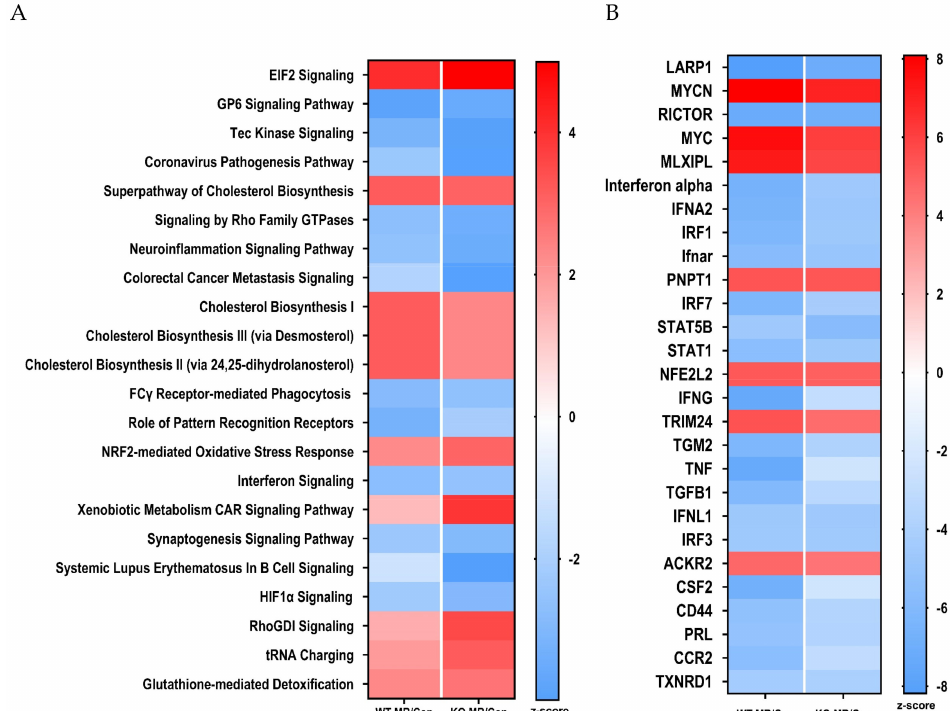
Figure 3. Bioinformatics analysis of hepatic gene expression in Nfe2l2 fl/fl (WT) and Nfe2l2 fl/(Alb) ( NRF2 KO) mice fed Con or MR diets for 8 weeks. Canonical pathway analysis ( A ) and upstream regulator analysis ( B ) were conducted using Ingenuity Pathway Analysis as described in the Materials and Methods. Pathway analysis was conducted using livers from 5 to 6 mice of each genotype × diet combination and utilized to identify putative gene regulators responsible for the observed transcriptional patterns produced by the MR diet compared to the Con diet in the two genotypes. Upstream regulators and canonical pathways with an activation z-score ≥ 2 or ≤ 2 were considered to be activated (red) or inhibited (blue), respectively. Heat maps were used to visualize the top 20 canonical pathways and upstream regulators that were differentially affected by the MR diet in the two